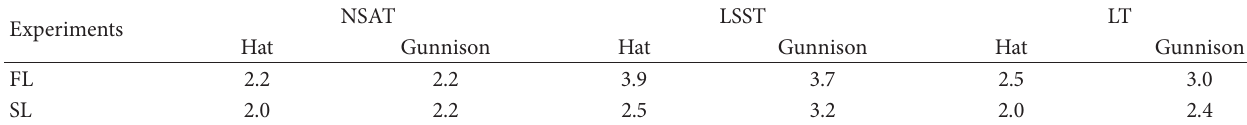
Table 1: RMSE ( ∘ C) between simulated and the observed temperature at Hat and Gunnison islands.